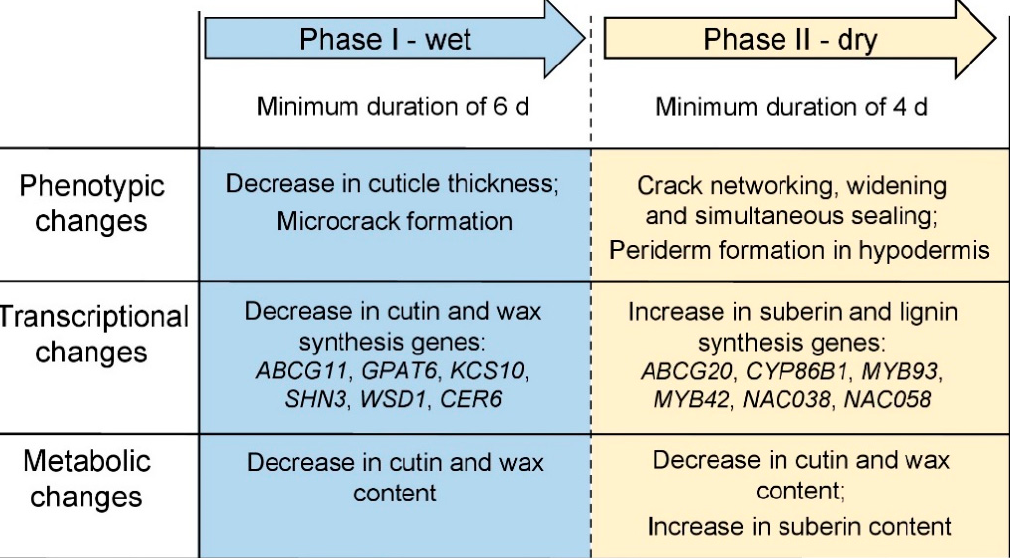
Figure 10. Schematic of the process of russeting at the phenotypic, transcriptional and metabolic level during exposure of apple fruit skin patches to moisture (Phase I) and following discontinuation of exposure (Phase II).